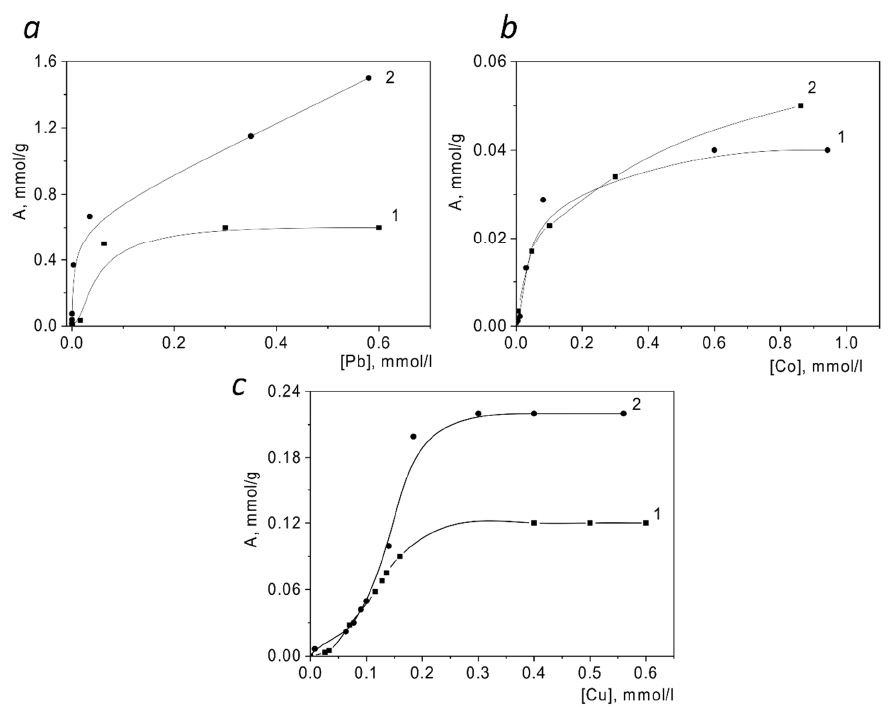
Figure 8. Adsorption isotherms of ( a ) Pb 2+ , ( b ) Co 2+ and ( c ) Cu 2+ on the surface of the synthesized composites Silochrom/PLA (1) and Silochrom ‐ NH 2 /PLA (2). Langmuir, Freundlich, and Temkin adsorption models were applied to evaluate the adsorption behavior of the composites. The characteristic parameters were calculated for each isotherm model and summarized in Table 3. According to the obtained data, all sys ‐ tems where metal ions are present in the form of aqua complexes (de ‐ ionized water) fit well with the Langmuir isotherm model. The fitting was confirmed by the high values of correlation coefficients (0.8–0.99). In the systems where metal ions were adsorbed by Silo ‐ chrom ‐ NH 2 /PLA composites, adsorption behavior could be described by the Freundlich isotherm model ( R 2 from 0.91–0.97). This could potentially be due to a more heterogene ‐ ous surface of the Silochrom ‐ NH 2 /PLA composite, and therefore potentially, more groups could be responsible for adsorption, resulting in multilayer adsorption with non ‐ uniform distribution of adsorption heat. Table 3. The isotherm model parameters obtained for Cu(II), Co(II), and Pb(II) ions adsorption onto Silochrom/PLA and Silochrom ‐ NH 2 /PLA composites. Isotherm Model/ Parameter, Unit Silochrom/PLA